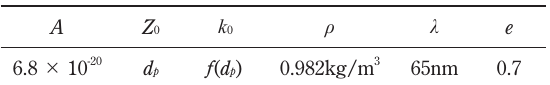
Table 1 Some parameters of dioctyl phthalate nanopar-